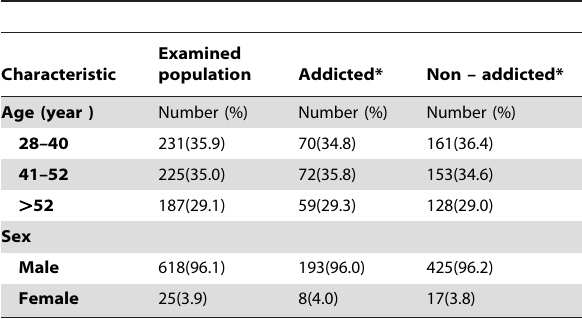
Table 2. Age and sex distributions of opium addicted and non – addicted cohorts.